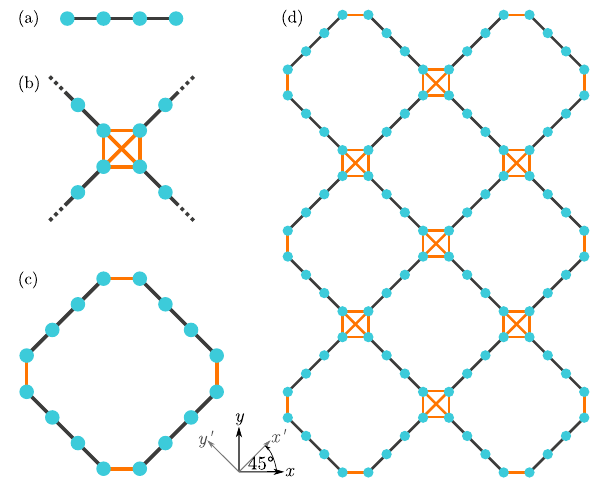
Fig. 1 Hardware topology of the proposed architecture. a Linear segment of m = 4 qubits (dots) connected by two-qubit operations (lines), representing split-gate transistors along a nanowire. b Hardware junction joining four linear qubit segments. Orange lines indicate two-qubit operations combined with spin shuttling. c Unit cell of the proposed architecture with m = 4 qubits in each segment. d Hardware graph of the proposed architecture with d x = 2 and d y = 3 unit cells in x and y directions,